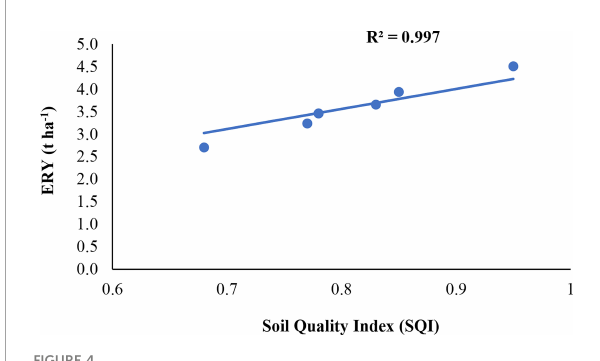
Relationship between soil quality index and equivalent rice yield as obtained through simple regression